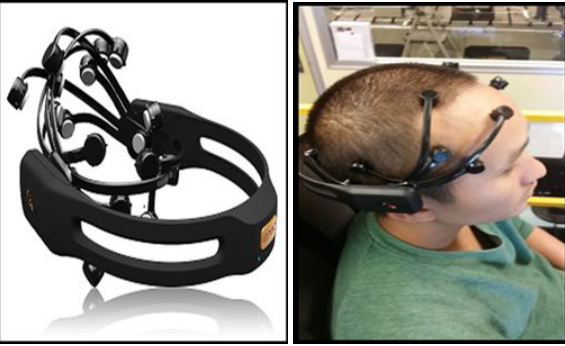
Fig. 3. Figure shows electrode placement on human